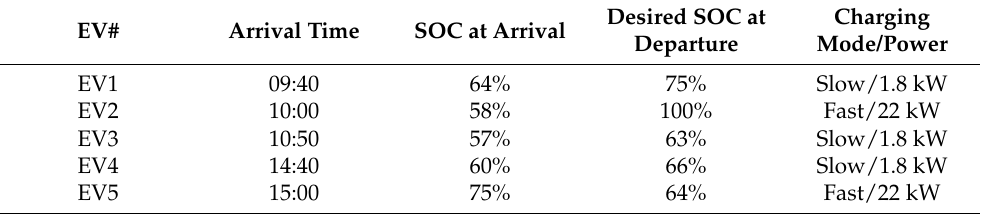
Table 7. Hypotheses for Scenario 2e.